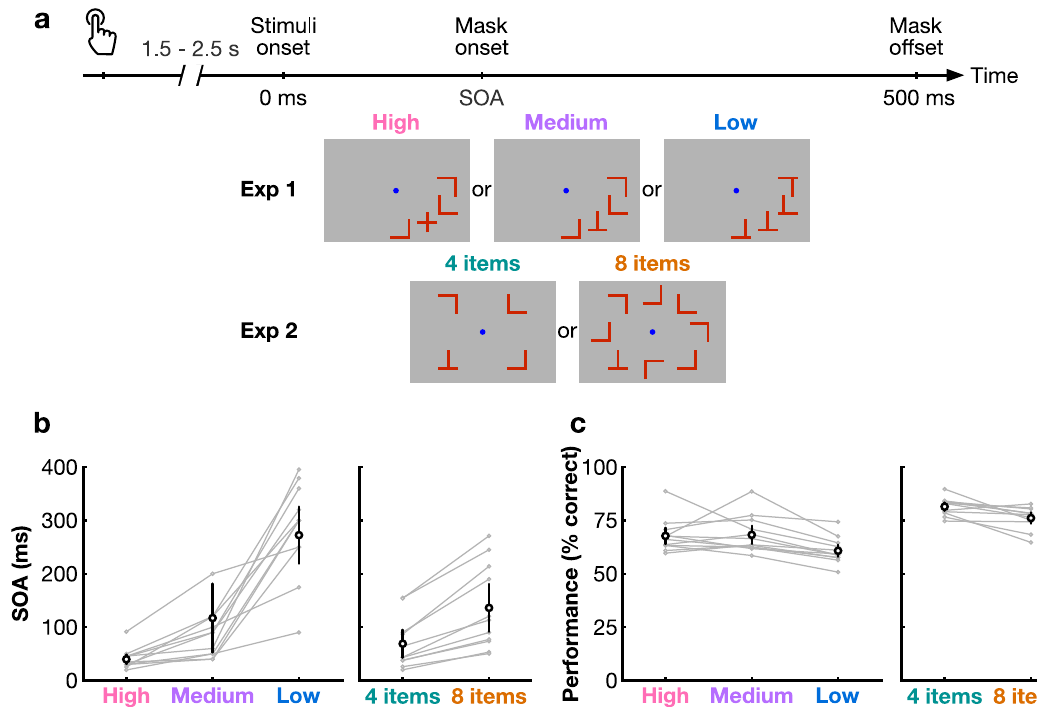
Figure 1. Task design and behavioral results. ( a ) A button press initiated by the participant began the trial. After a random duration between 1.5 and 2.5 s, the search array appeared. In Experiment 1, the item shape was manipulated (blocked) to yield high (the target is a +), medium and low (the target is a T) discriminability conditions (always 4 items). In Experiment 2, the number of items was manipulated (4 or 8, interleaved; the target is always a T). The items remained onscreen for the duration of the participant’s titrated SOA, immediately followed by masks, which disappeared after 500 ms from stimuli onset. After mask offset, the participant pressed a button to indicate whether the target was present or absent, ending the trial. The central fixation dot was always present. ( b ) Stimuli duration (SOA) for Experiment 1 (left) and Experiment 2 (right) for each condition. ( c ) Performance expressed as the percentage of correct responses (detecting the presence or absence of the target). Black circles represent the group average performance. Error bars represent the 95% confidence interval. Gray traces show results for individual